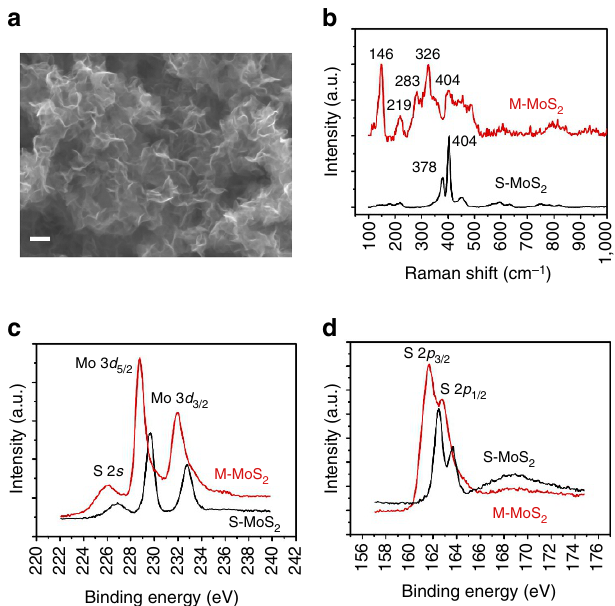
Figure 1 | Morphology of M-MoS 2 and phase identification of M-MoS 2 and S-MoS 2 . ( a ) SEM image of M-MoS 2 showing the nanosheet structures. Scale bar, 100nm. ( b ) Raman shift of M-MoS 2 and S-MoS 2 . ( c , d ) High-resolution X-ray photoelectron spectroscopy (XPS) spectra of Mo 3 d ( c ) and S 2 p ( d ) for M-MoS 2 and S-MoS 2